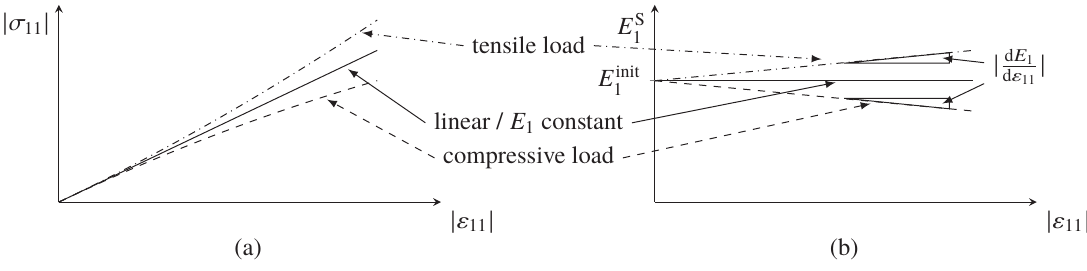
Figure 4. Schematic representation of the stress–strain curves for loads in fiber direction ( a ) and the principle to determine the slope d E 1 / d ε 11 and the static modulus E init